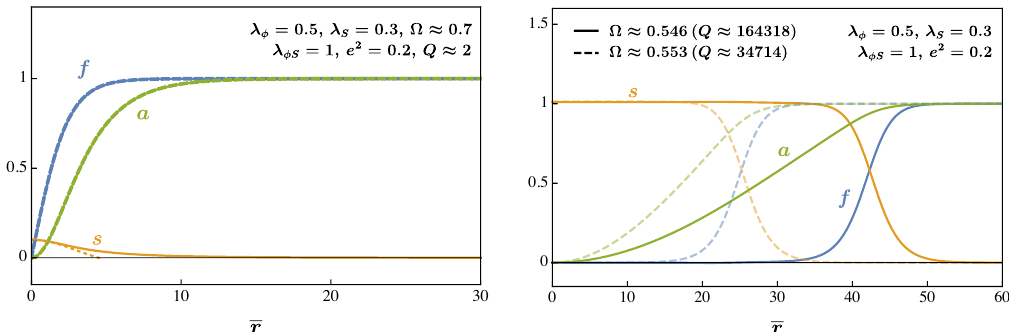
Figure 1 . Example QMB field configurations for small (left) and large (right) S charge Q . Both panels take m S, 0 = 0 and q = 2 . In the left panel, the dashed blue and green lines indicate the Q = 0 solution for an isolated monopole with the same λ φ and e , which is barely distinguishable from the Q = 2 field profiles (solid) for a and f . The dotted yellow line shows s 0 sin(Ω r ) / (Ω r ) , which well approximates the small-radius solution for s in the small Q regime. In the right panel, two different choices for large Q are shown in solid and dashed